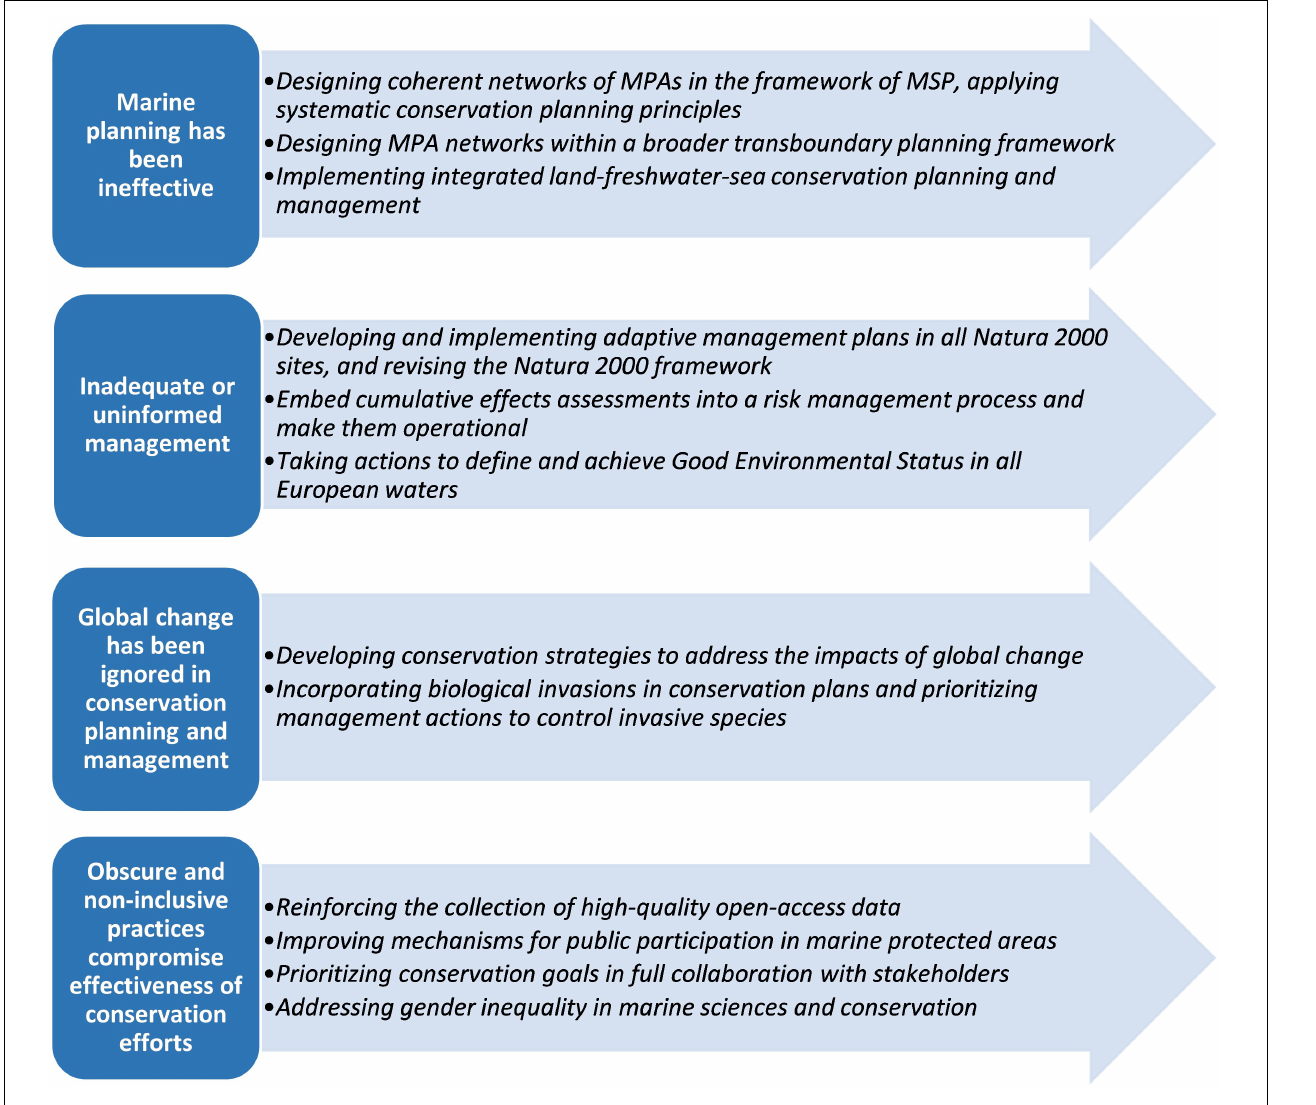
FIGURE 2 | Shortfalls of marine conservation efforts in European and contiguous seas, and main recommendations to advance marine